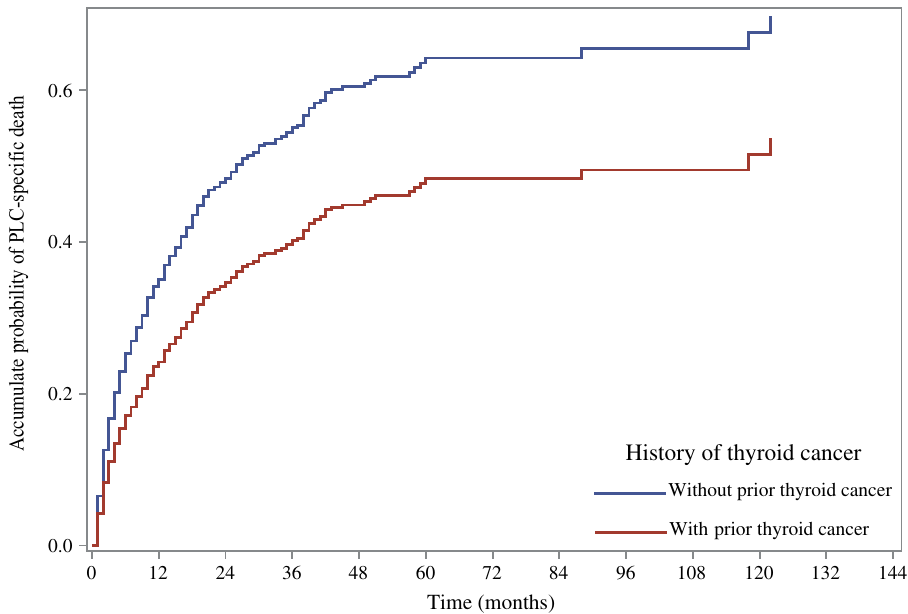
Figure 2. The cumulative incidence of PLC-specific death in PLC patients with and without prior thyroid cancer. PLC primary liver cancer.